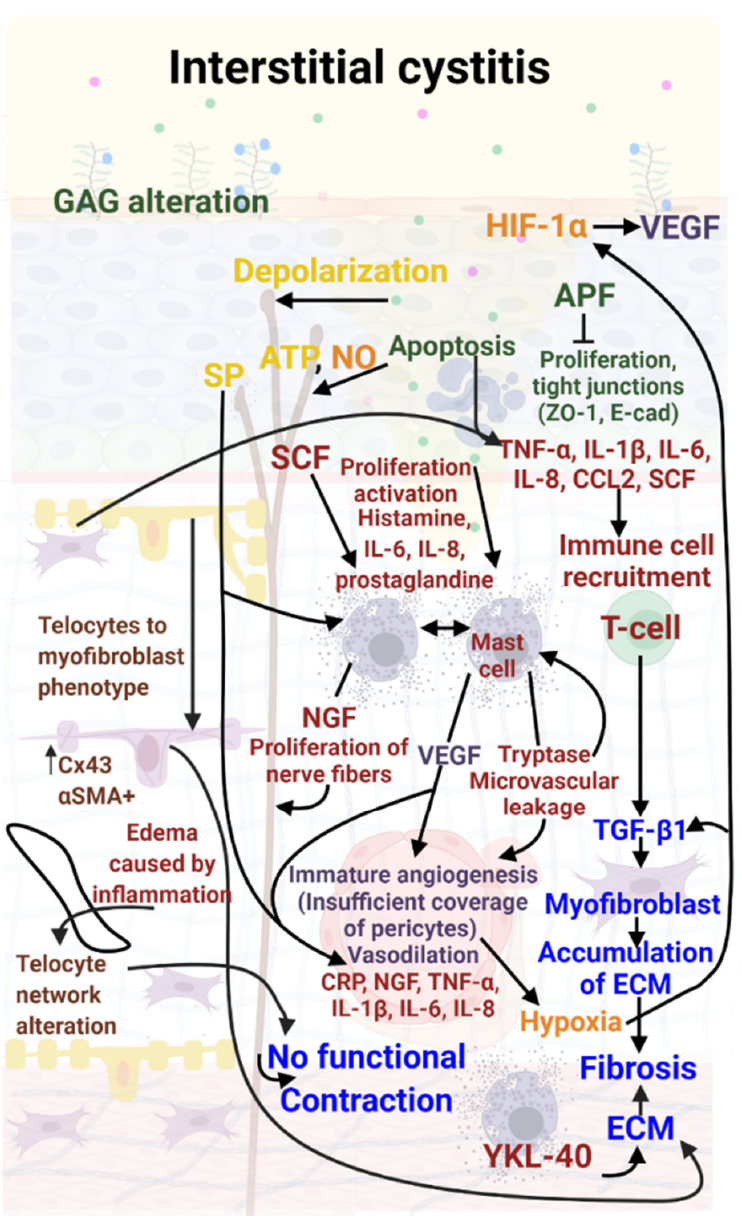
Figure 2. Molecular mechanisms involved in Interstitial Cystitis (IC). Bladder mucosa lesions induce inflammation mediated by IL-6, IL1 β , IL 8, CCL2 and TNF α to recruit T cells and mast cells. Mast cells produce tryptases and VEGF inducing vascular injury, creating hematuria and reinforcing inflammation. T lymphocytes produce TGF- β 1 inducing the transdifferentiation of fibroblasts into myofibroblasts. These myofibroblasts produce large amounts of ECM inducing fibrosis. Nerve dam- age due to potassium in urine and NGF produced by mast cells induces incomplete and intermittent contraction. Color code: red: inflammation; green: urothelial damage; blue: fibrosis, purple: vascular damage; orange: hypoxia, yellow: neuro-inflammation; brown: telocyte damage. Hemorrhagic